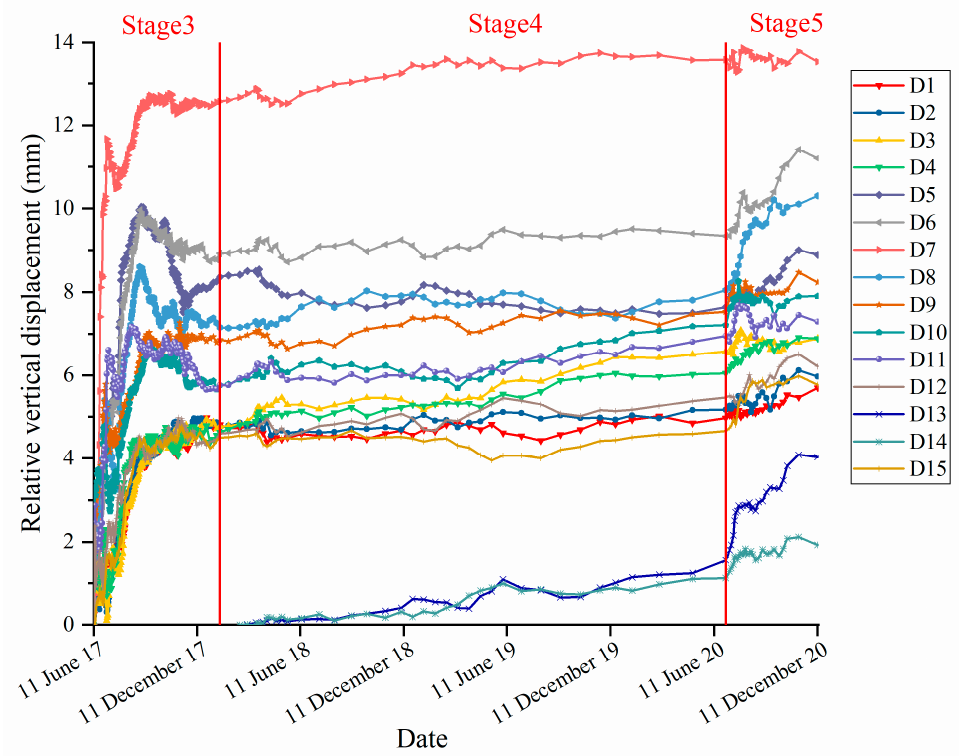
Figure 14. Cumulative vertical displacement monitoring data of 15 surface displacement monitoring points from 11 June 2017 to 12 December 2020. Their positions are shown in Figure 6.